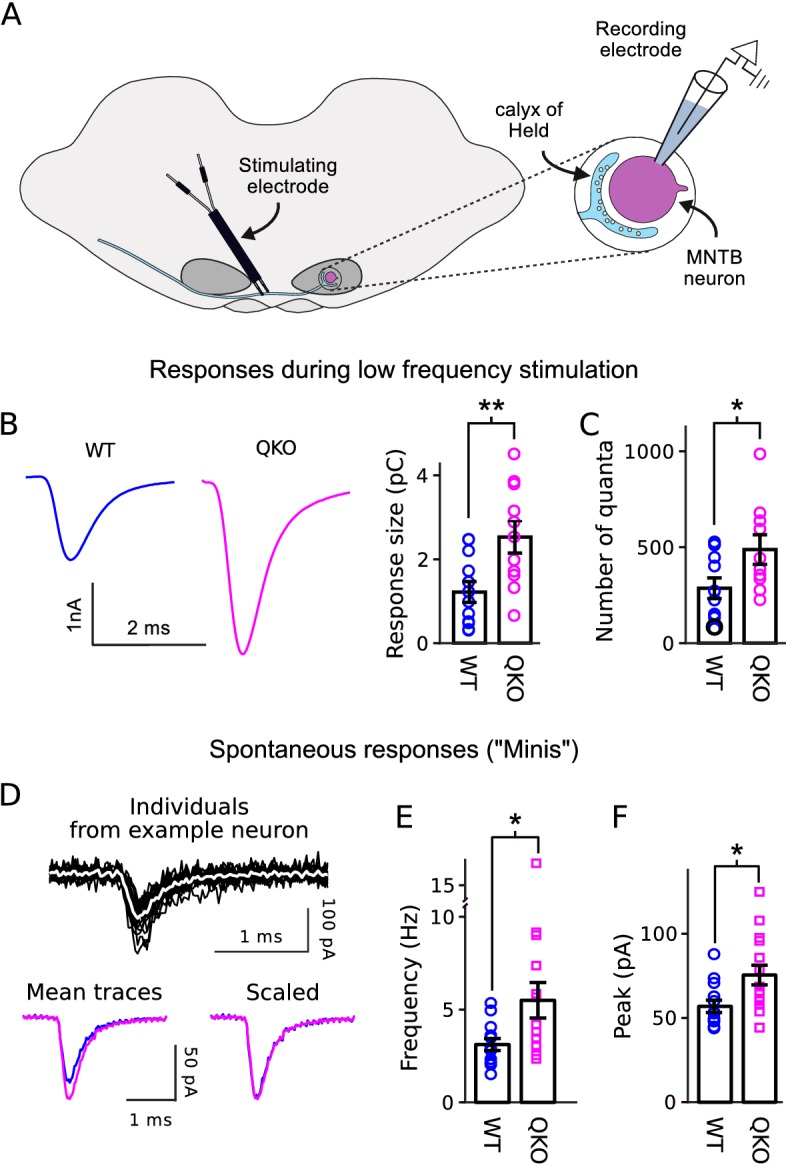
Increased transmitter release at QKO calyces of Held.(A) Diagram of calyx of Held preparation; MNTB is the medial nucleus of the trapezoid body. (B) Larger responses at QKO synapses after isolated/low frequency presynaptic action potentials (i.e., each after at least 1 min of rest). Traces are average responses across all preparations; n ≥ 11 calyces for both WT and QKO, each from a separate slice; experimenter was blind to genotype; extracellular 1mM kynurenic acid was used throughout. (C) Response sizes from (B) after normalizing by quantal size calculated as in Mahfooz et al. (2016). (D-F) Analysis of spontaneous responses recorded before adding kynurenic acid; n ≥ 13 calyces for both WT and QKO. (D) Black traces are overlay of all individuals from a single QKO neuron. The white trace is the mean that was used later for quantification. Mean traces are means of all individuals across all preparations. (E and F) Data points correspond to single preparations. Bars are mean ± s.e.m.; *p < 0.05; **p < 0.01; Wilcoxon rank sum.